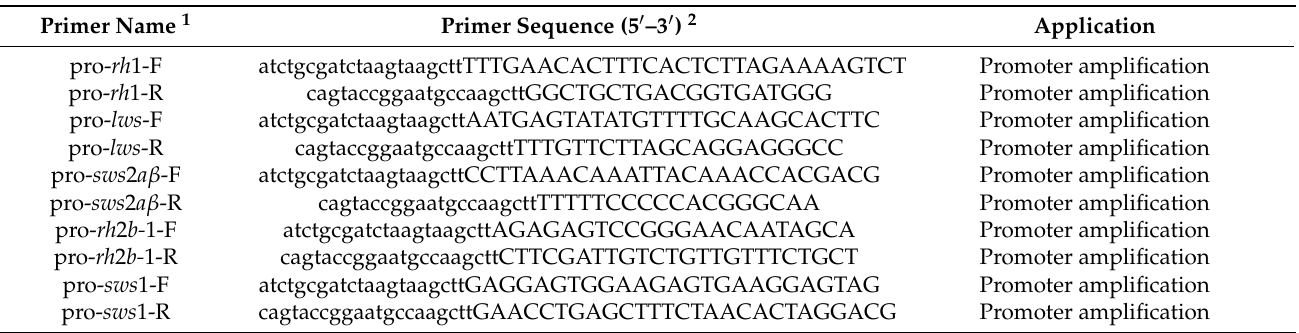
Table 2. Primers used in the